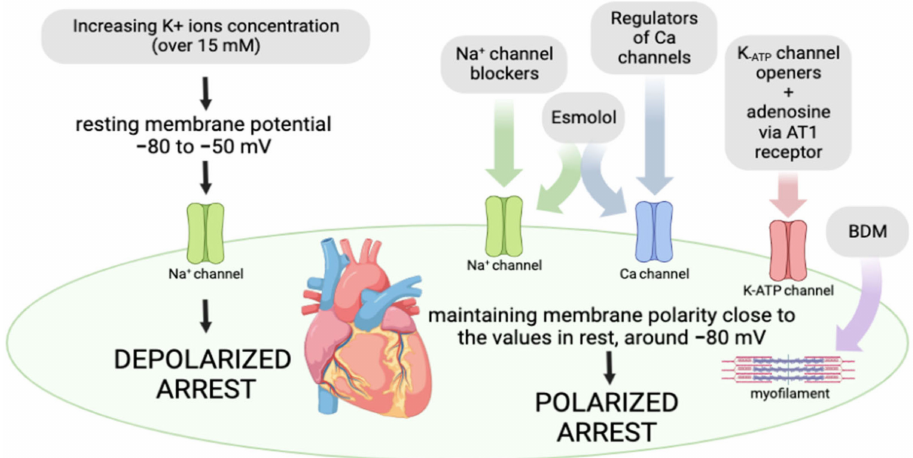
Figure 3. Targets for achieving depolarized and polarized